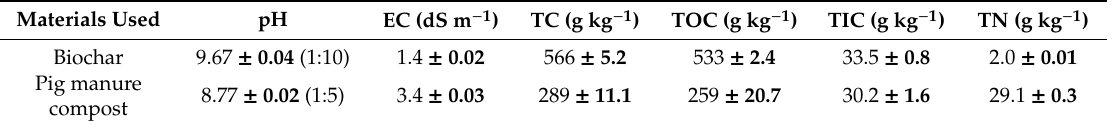
Table 1. Chemical properties of biochar and pig manure compost used 1